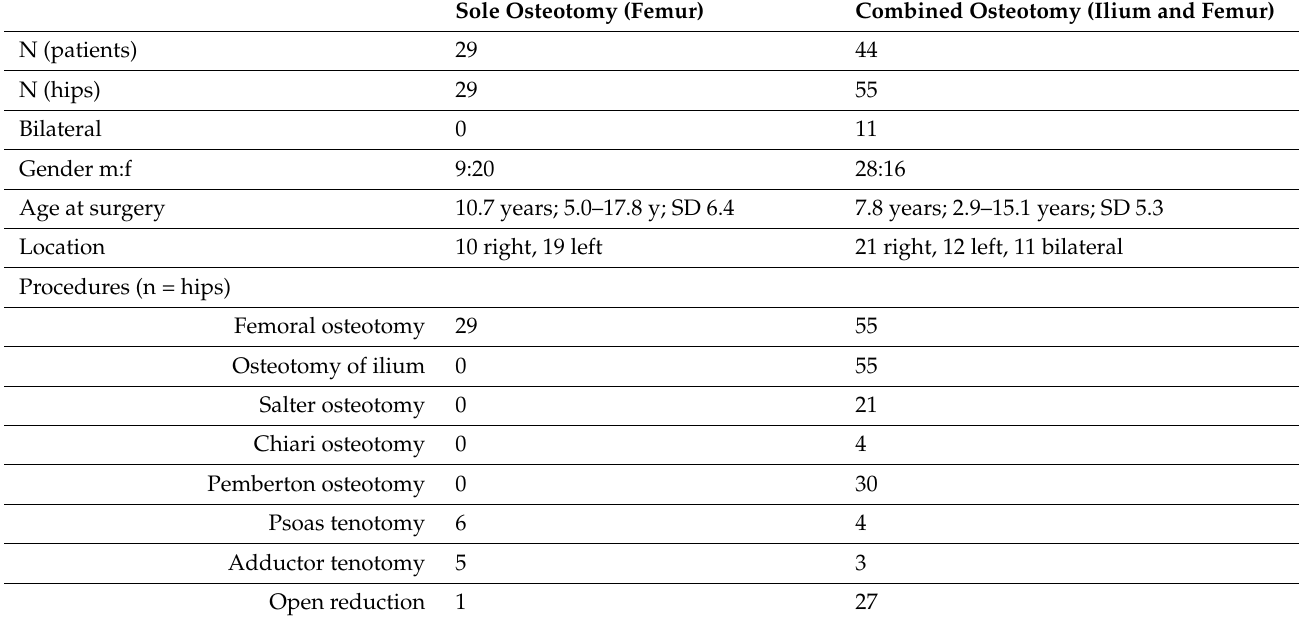
Table 2. Patient groups and surgical procedures in detail